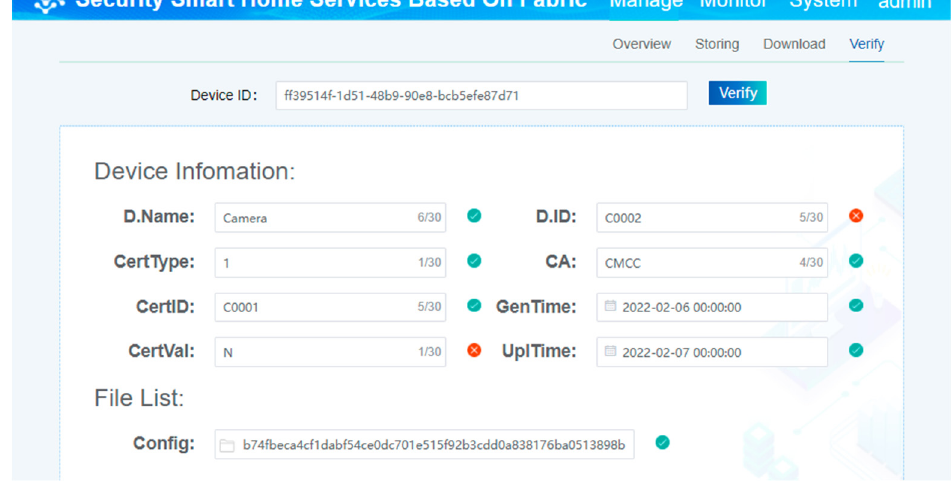
Figure 12. The process of verifying the current information based on the chain.